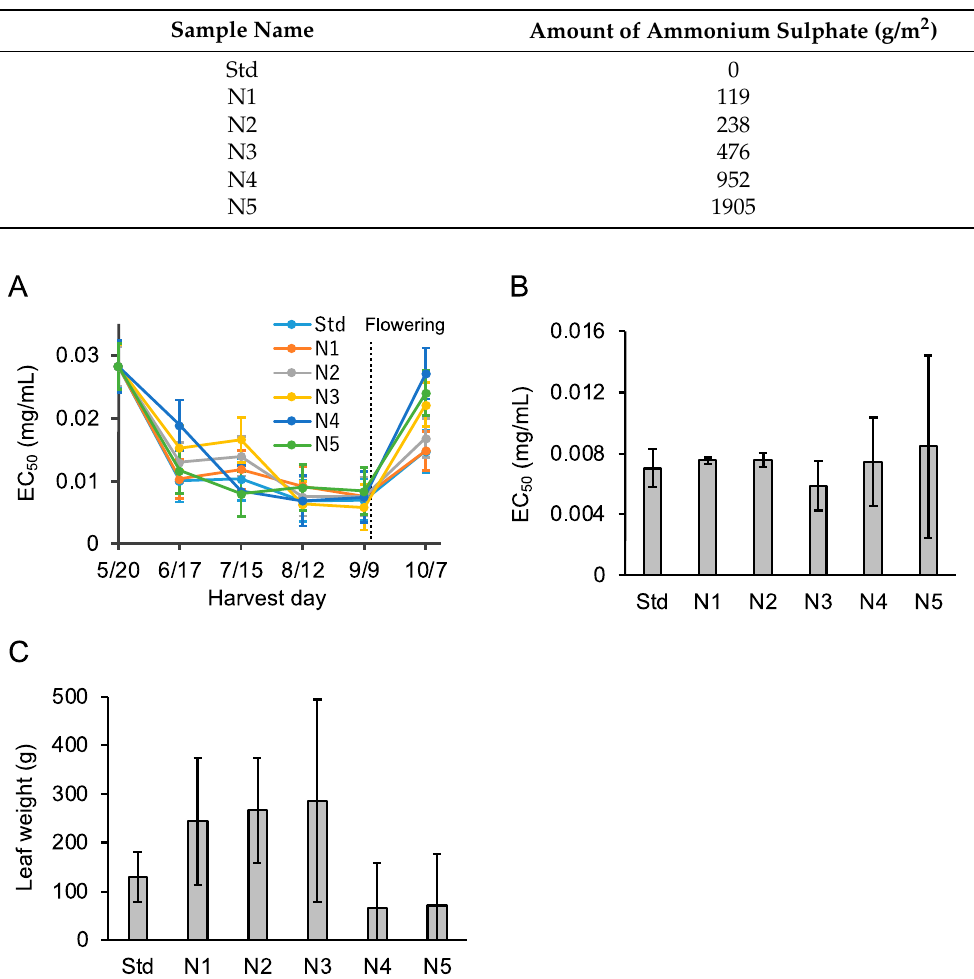
Table 2. Fertilizer conditions of nitrogen in 2020.